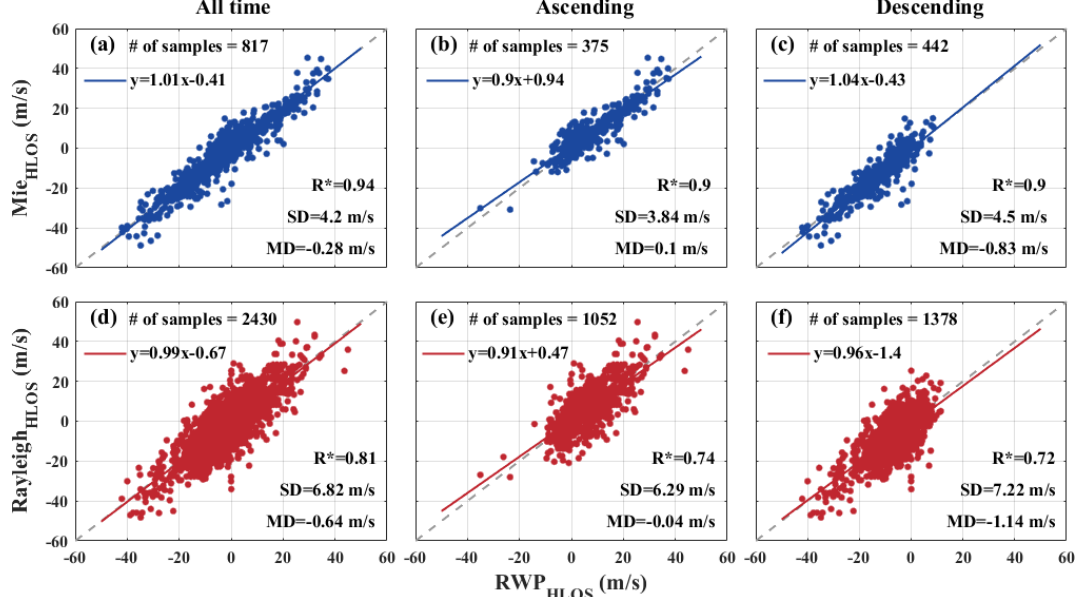
Figure 5. Aeolus against RWP HLOS winds for (a, b, c) Mie-cloudy winds and (d, e, f) Rayleigh-clear winds for (a, d) all data and (b, e) ascending and (c, f) descending orbits. Corresponding least-square line fits are indicated by the solid lines. The fit results are shown in the insets. The 1 : 1 line is represented by the gray dashed line.